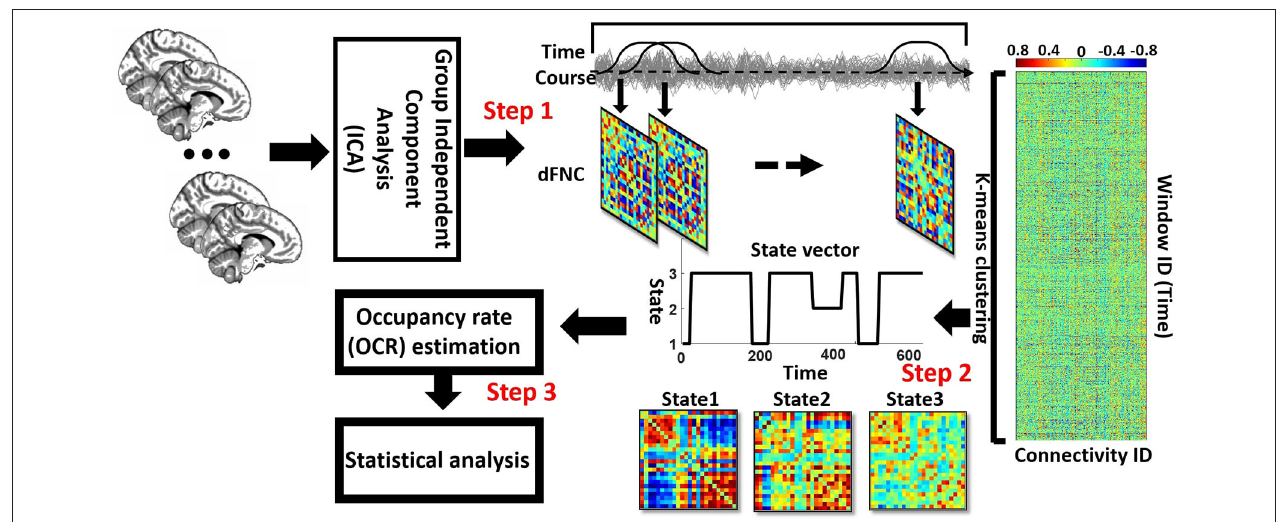
FIGURE 1 | Analytic pipeline: The time-course signal of 24 components of the CCN and DMN networks has been identified, using group-independent component analysis (ICA). In step 2, a taper sliding window was used to segment the time-course signals and then calculated the functional network connectivity (FNC). After vectorizing the FNC matrixes, we have concatenated them, and then k-means clustering, k = 3, was used to group FNCs into three distinct states (Step 2). Elbow criteria were used to find the optimal k. In addition, the L1 distance metric is used in this clustering. Then, based on the state vector of each subject, the occupancy rate or OCR features-in total, three features-were calculated from the state vector of each subject. Then we compared the OCR among the groups by using a ks-test. Then, we adjusted all p-values by the Benjamini-Hochberg false discovery rate (FDR) correction in each analysis (Step